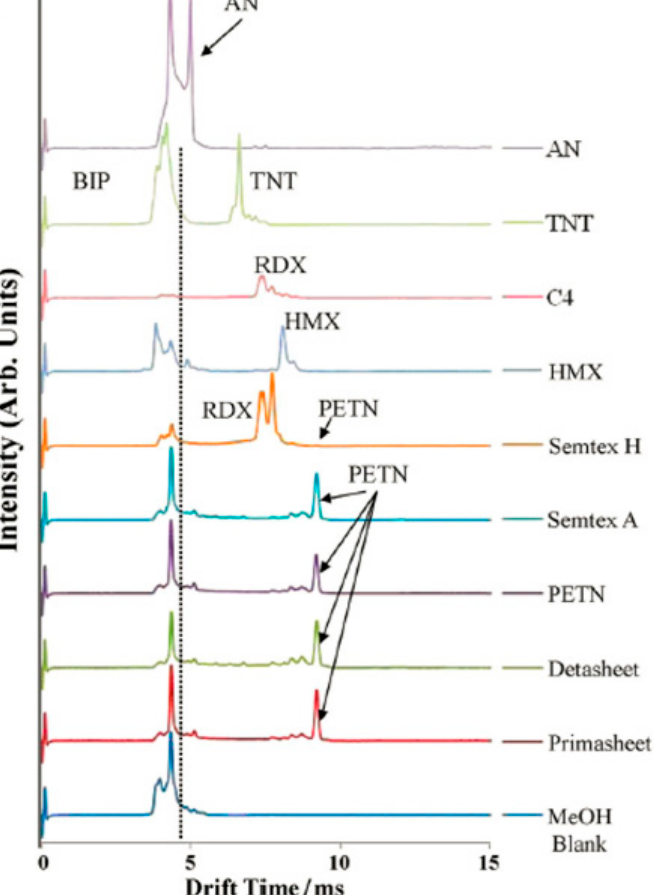
Figure 16. Ion mobility spectra of different explosives. Adapted from [132], with permission from © 2010 Elsevier.